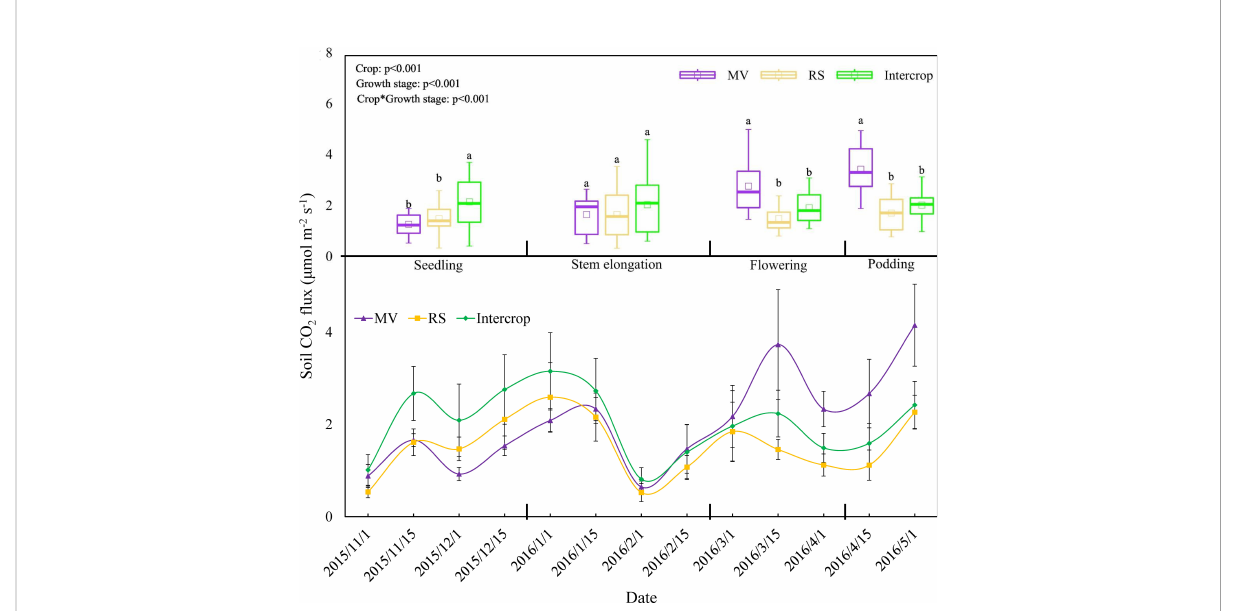
FIGURE 3 Effects of crop systems on soil respiration. Means are n=24 (seedling and stem elongation stages), n=18 ( fl owering stage) n=12 (podding stage) (these differences in replicates are because of the length of every growth stage was different) and standard deviations of each growth stage are show. Letters indicate signi fi cant differences among crop systems at P